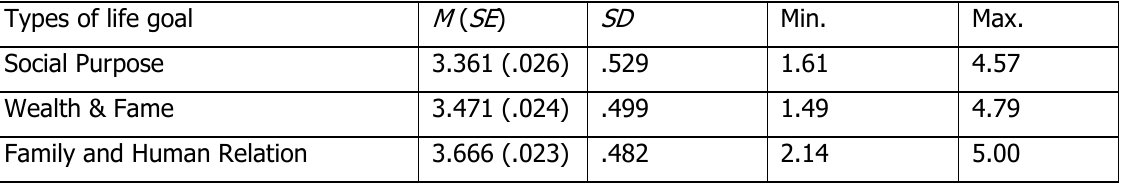
Descriptive statistics of the life goals (n = 412)